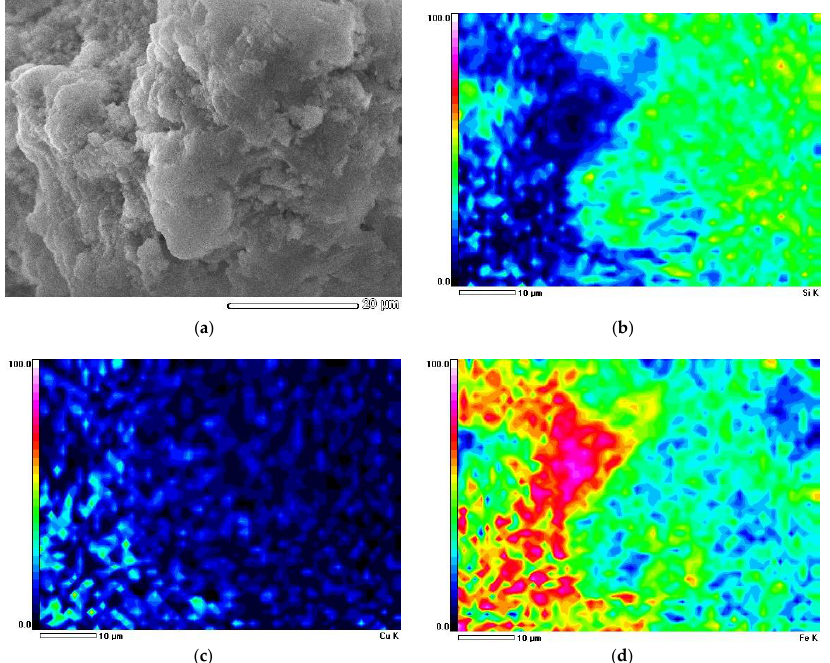
Figure 13. XRD pattern of desilicated concentrate ( a ), and the product of its leaching in ammonia solution ( b ). The cakes after desilication have a relatively uniform distribution of the above elements, especially Si, which is explained by the formation of sodium hydroaluminosilicates on the surface of copper and iron minerals (Figure 12b). The cakes after the pressure ammonia leaching of desilicated concentrate were also analyzed by scanning electron microscopy to assess morphological changes. The SEM and map-scanning images obtained for the ammonia pressure leaching cake of the desilicated concentrate are presented in Figure 14.